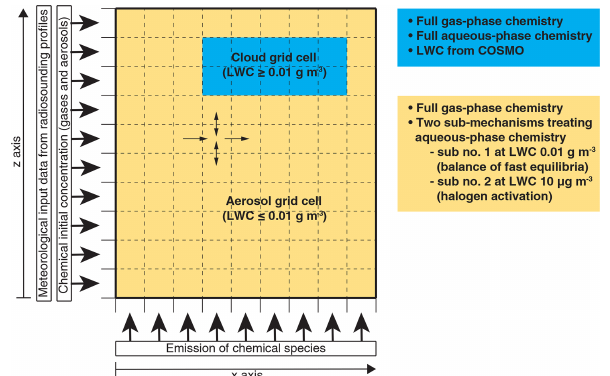
Figure 3. Schematic representation of the multiphase chemistry treatment in COSMO-MUSCAT in an idealized 2D